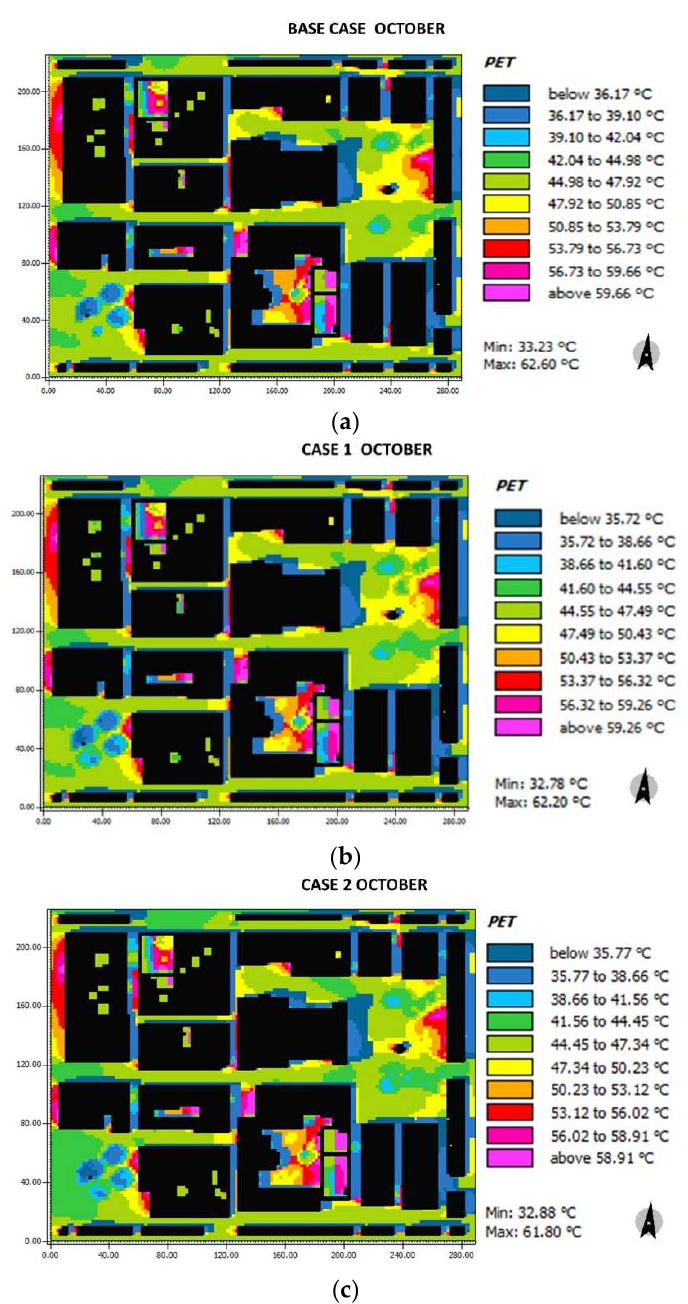
Figure 16. Results maps for pet, for October at 15:00: ( a )base case, ( b ) case 1, and ( c ) case 2.